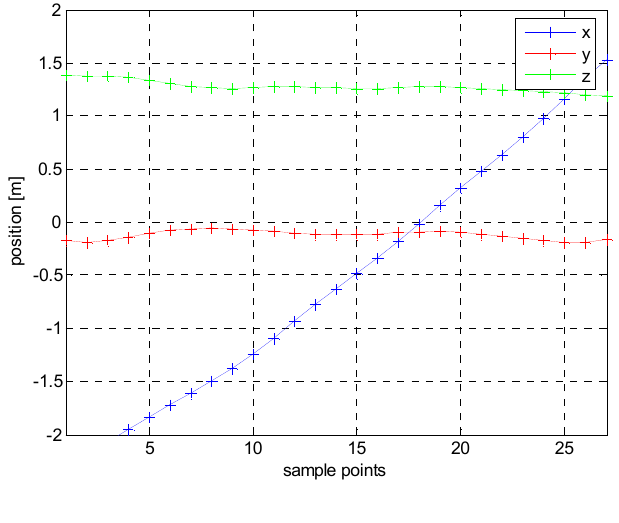
Figure 6. The calculated trajectory after the second round of